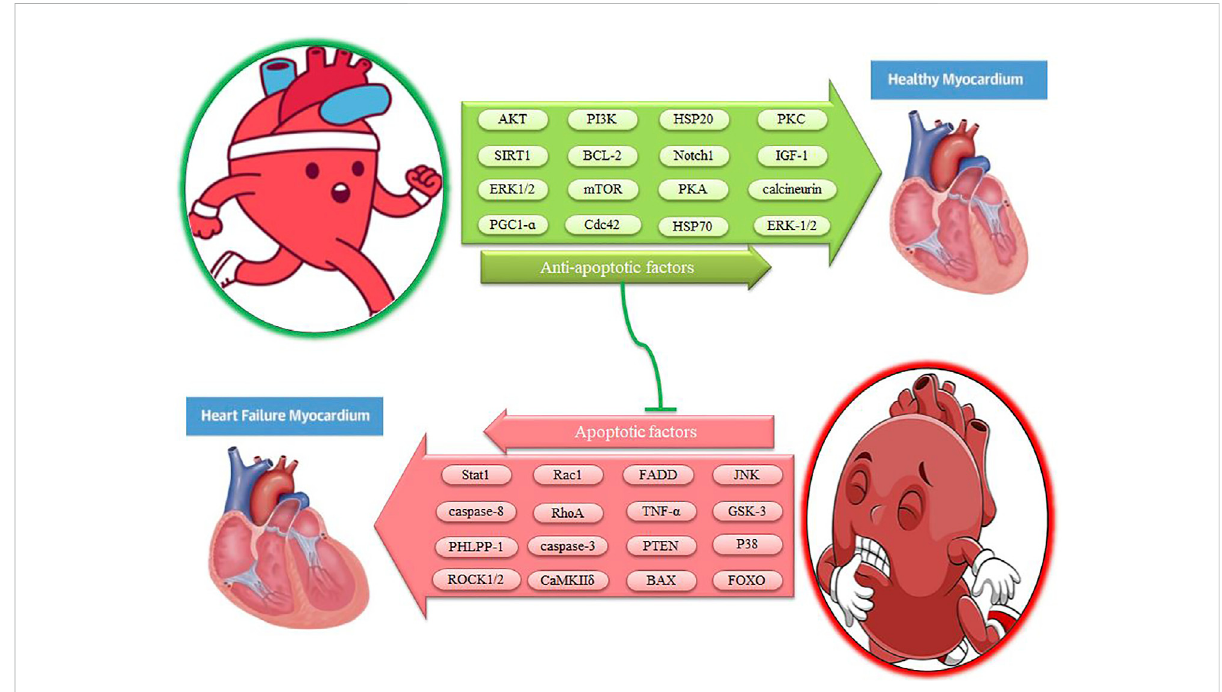
FIGURE 3 The effect of exercise on myocardial apoptotic factors. Description is available in the